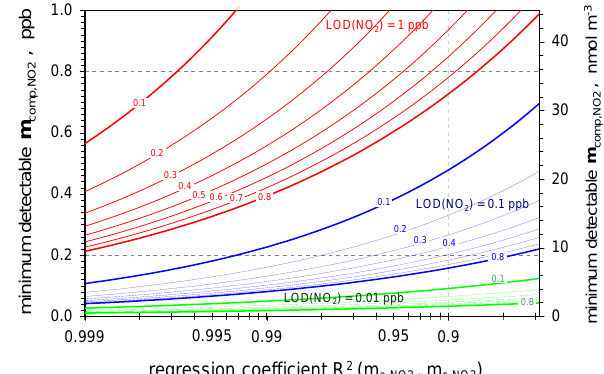
Fig. 2. The dynamic plant chamber at well defined (labora- Figure 2. The dynamic plant chamber at well defined (laboratory) conditions: minimum 3 tory) conditions: minimum detectable NO 2 compensation point detectable NO 2 compensation point concentrations ( m comp,NO2 at P  0.999, i.e. “highly 4 concentrations ( m comp,NO at P ≥ 0.999, i.e. “highly signifi- 2 significant”) as function of NO 2 deposition velocity ( v dep,NO2 ; per leaf area) and the goodness 5 cant”) as function of NO 2 deposition velocity ( v dep,NO ; per 2 ( R 2 ) of the ambient vs . sample NO 2 concentration measurements (standard errors of NO 2 6 leaf area) and the goodness ( R 2 ) of the ambient vs. sam- concentration measurements considered). Results are from data simulation (random number 7 ple NO 2 concentration measurements (standard errors of application) matching pre-scribed R 2 ( m a,NO2 , m s,NO2 ) and prescribed v dep,NO2 (0.999  R 2  0.6 8 NO 2 concentration measurements considered). Results are and v dep,NO2 = 0.1, 0.2,…, 0.8 mm s -1 ). The greenish range represents simulated data of a 9 from data simulation (random number application) match- ing pre-scribed R 2 ( m a,NO , m s,NO ) and prescribed v dep,NO 2 2 2 (0.999 ≤ R 2 ≤ 0.6 and v dep,NO =0.1, 0.2, ..., 0.8mms − 1 ). The 2 greenish range represents simulated data of a NO 2 analyzer with LOD( m NO )=0.4nmolm − 3 (0.01ppb), the bluish range 2 ) =4.5nmolm − 3 (0.1ppb), the reddish range for LOD( m NO 2